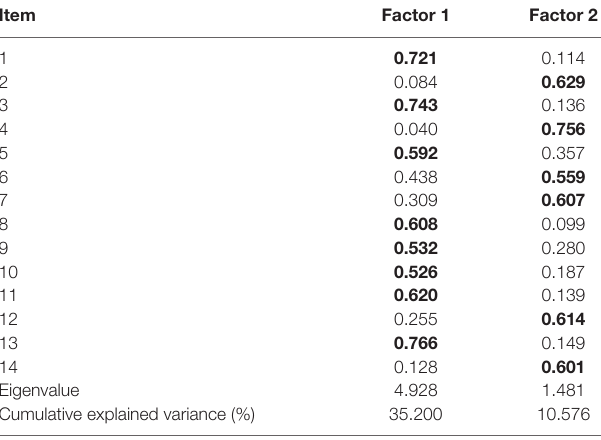
TABLE 2 | Results for the exploratory factor analysis of the